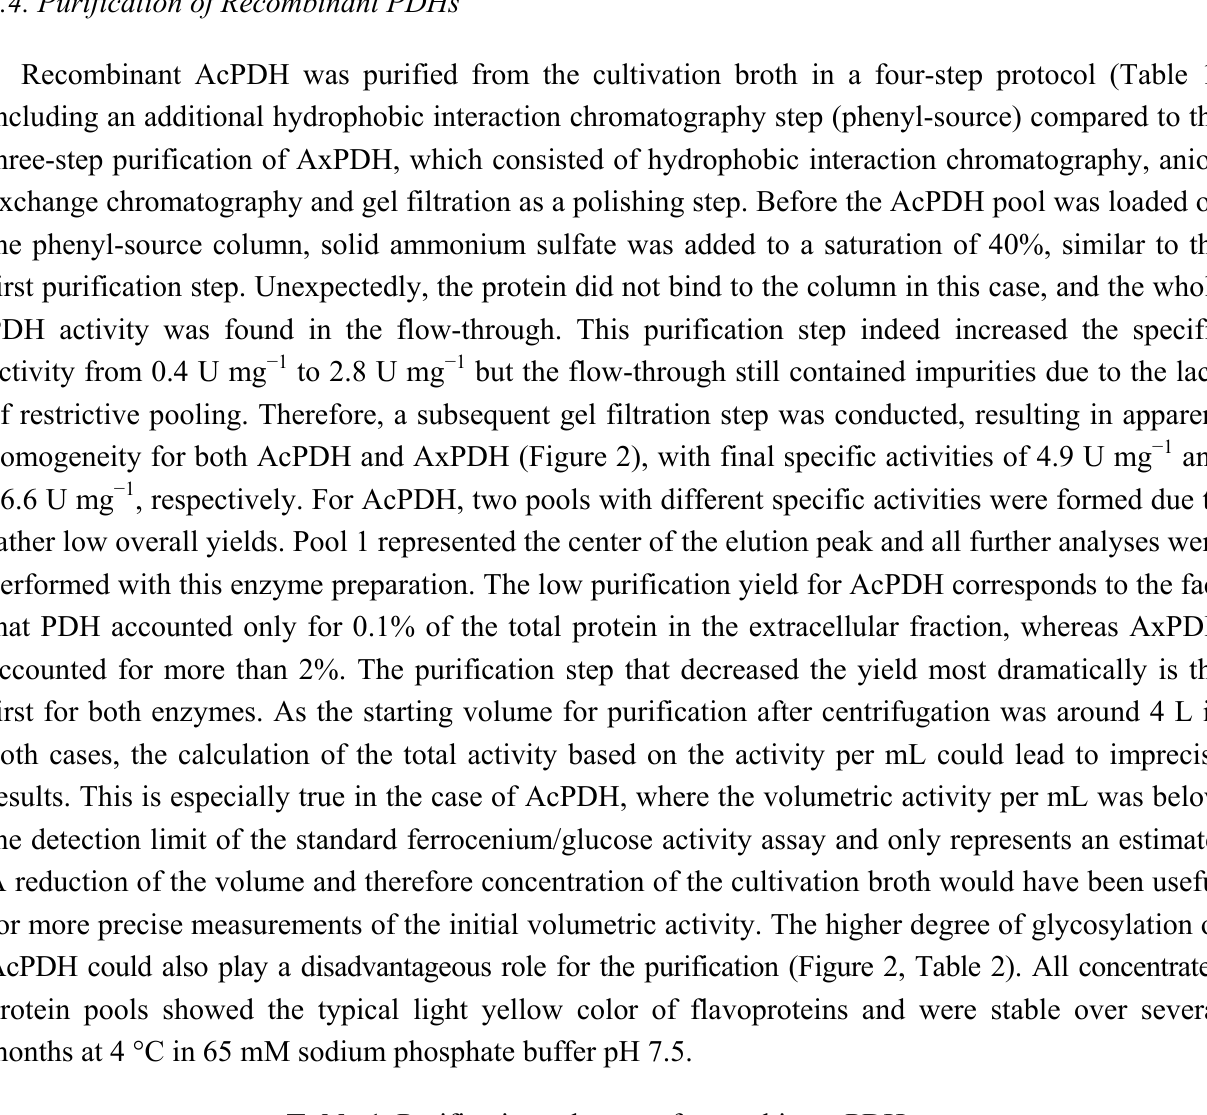
Table 1. Purification schemes of recombinant